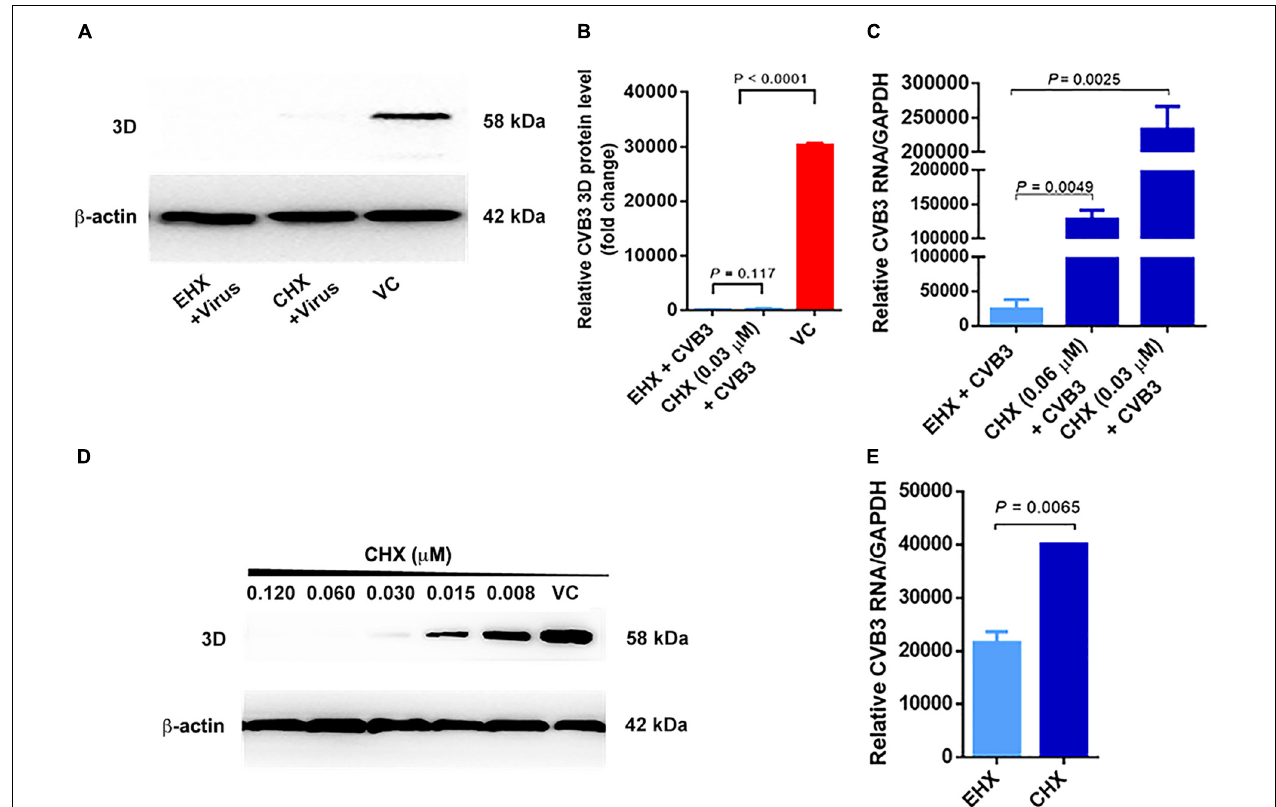
FIGURE 6 | Viral RNA transcription step is the molecular target of EHX. (A–C) EHX and CHX significantly suppressed CVB3 RNA and 3D protein level. HeLa cells were infected with CVB3 (MOI = 1) and were treated with EHX (8 µ M) and CHX (0.03 and 0.06 µ M), respectively. Total protein and RNAs were extracted at 18 hpi and analyzed using Western blotting and RT-qPCR, respectively. (D) CHX minimum inhibitory concentration. HeLa cells were infected with CVB3 (MOI = 1) and were cultured in medium containing CHX at the indicated concentrations. Extracted total protein was analyzed using Western blotting at 18 hpi. (E) EHX reduced mini-CVB3 RNA. HeLa cells were transfected with mini-CVB3 (1 µ g) and were treated with EHX (8 µ M) and CHX (0.03 µ M), respectively. Total RNAs were extracted 24 hpt and analyzed using RT-qPCR. Error bars represent SD, n = 3, Student’s t- test. CHX, cycloheximide; EGFP-C1, enhanced green fluorescent protein control